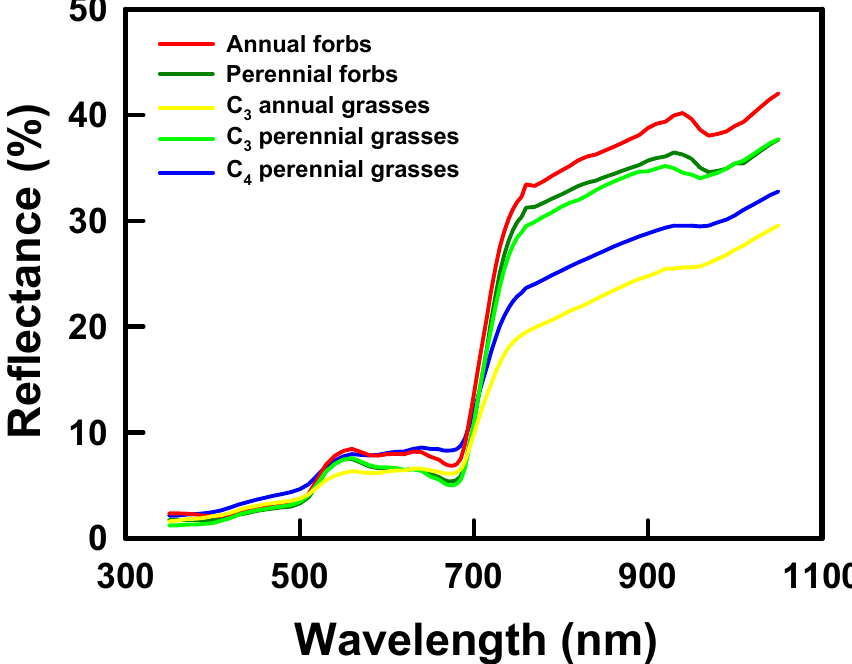
Figure 2. Mean values of reflectance as a function of wavelength for 76 cm diameter plots that differed in functional group dominance. Reflectance per waveband was averaged across plots in which a given functional group contributed >50% of plant cover (n = 4–6 plots per group).